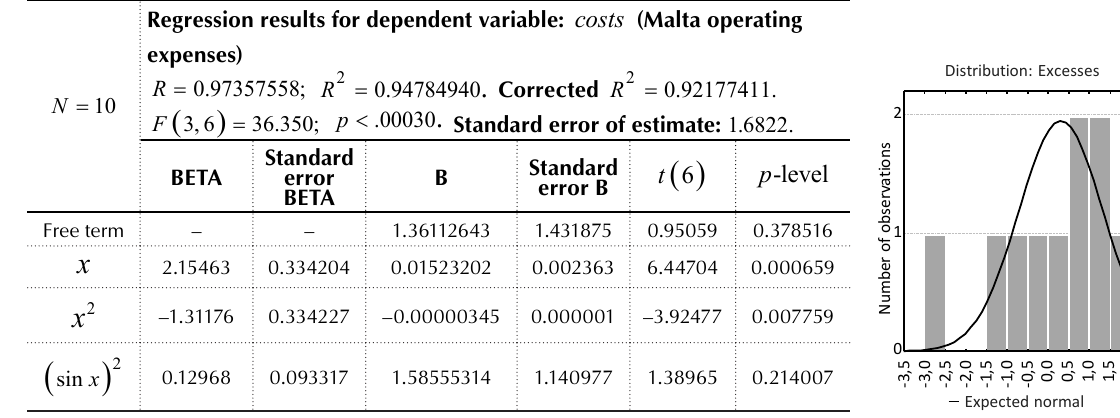
Table 7c. The results of regression for operating costs of the Investor Compensation Scheme (Malta) e from the volume of the fund ( )